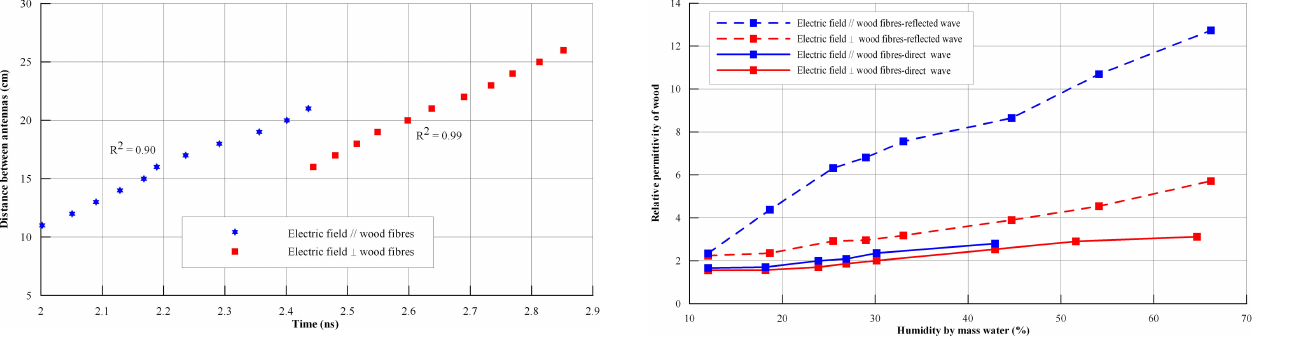
Figure 5. Determination of the propagation velocity for the direct wave from the arrival times. Both configurations with electric field parallel and perpendicular to the fibres are considered. In this case the humidity level was 18.18%. R 2 is the coefficient for the deter- mination of linear dependence.